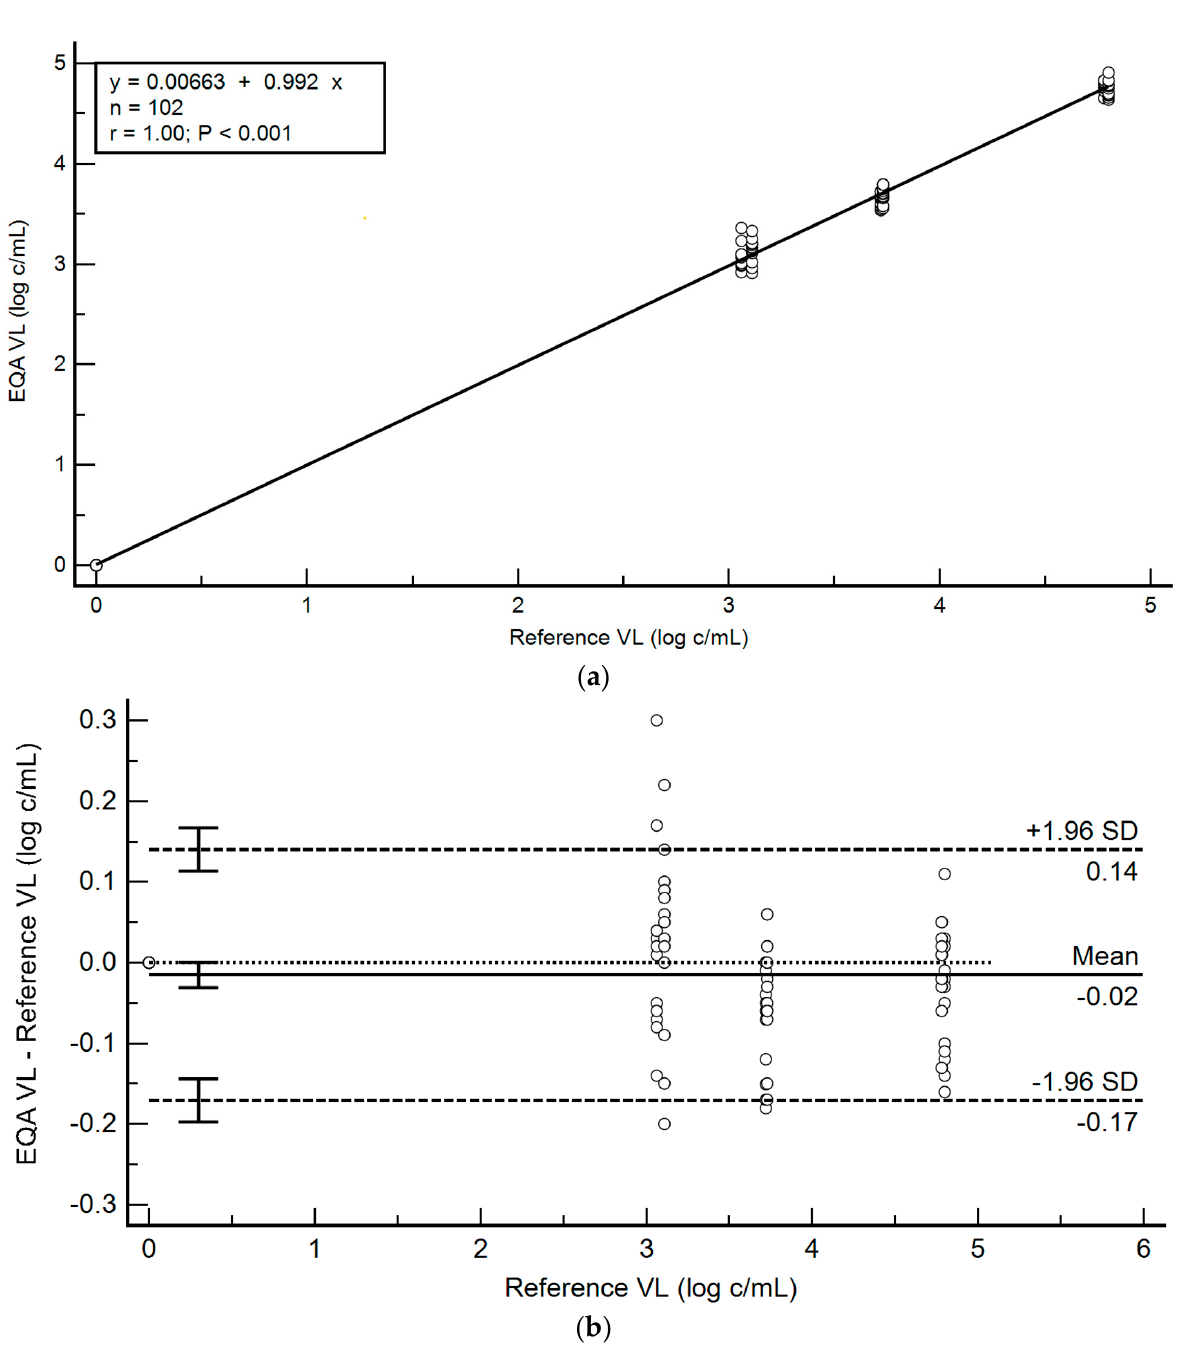
Figure 3. EQA Panel VL variation (log cp/mL) across different testing sites (n = 13) and EQA panels (n = 2). ( a ) Regression analysis for EQA Panels 1 and 2 (n = 102/104 specimens). ( b ) Bland-Altman agreement of the viral load results (n = 102/104 specimens), compared to the reference result obtained at panel preparation. EQA: external quality assessment. VL: viral load. cp/mL: copies per milliliter. SD: standard deviation. Table 3. Site EQA Summary: September 2017–November 2018.